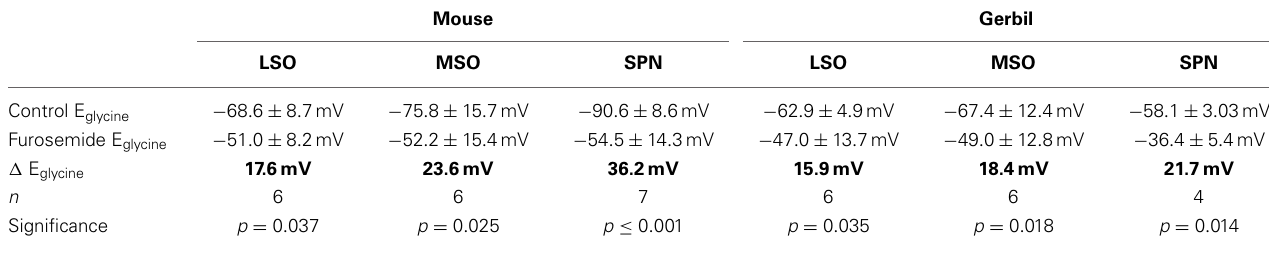
Table 1 | Suppression of KCC2-activity measured as shift in E glycine by 0.5mM furosemide across different nuclei and species.